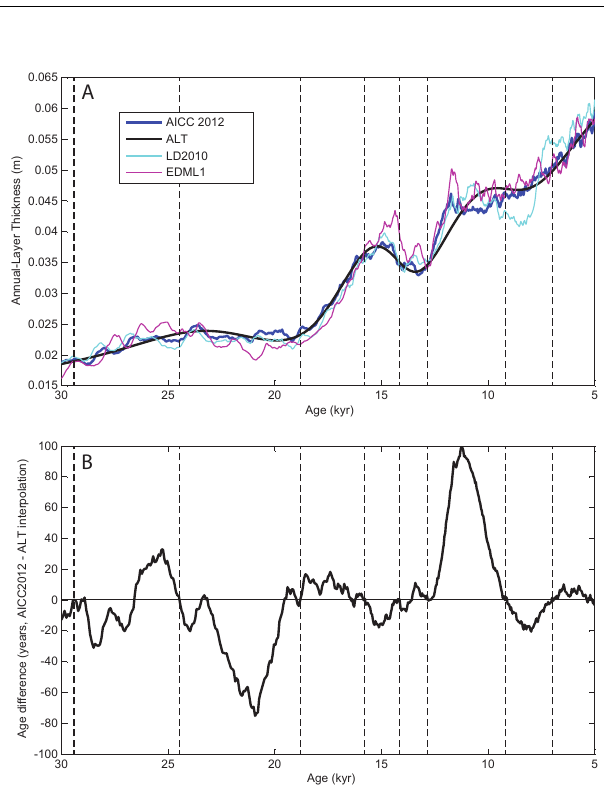
Figure 6. (A) Annual-layer thicknesses for three EDML timescales – AICC2012 (Veres et al., 2013), LD2010 (Lemieux-Dudon et al., 2010), and EDML1 (Ruth et al., 2007) – and the ALT interpolation based on ice ages from AICC2012. (B) Age differences between AICC2012 and ALT interpolation. Age differences between other timescales are not shown because only the AICC2012 and ALT use the same ages for tie points. Dashed vertical lines are tie-point ages.